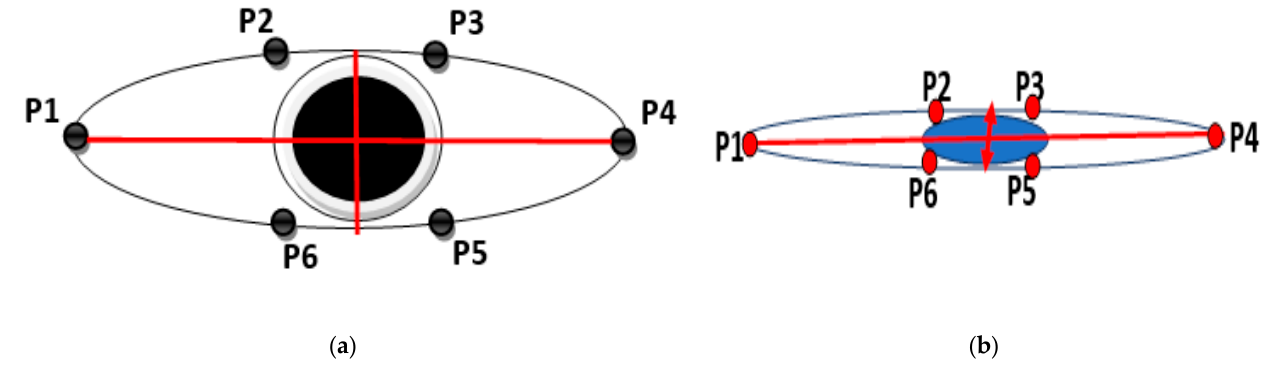
Figure 2. Open and closed eyes with facial landmarks (P1, P2, P3, P4, P5, P6). ( a ) Open eye. ( b ) Close eye.